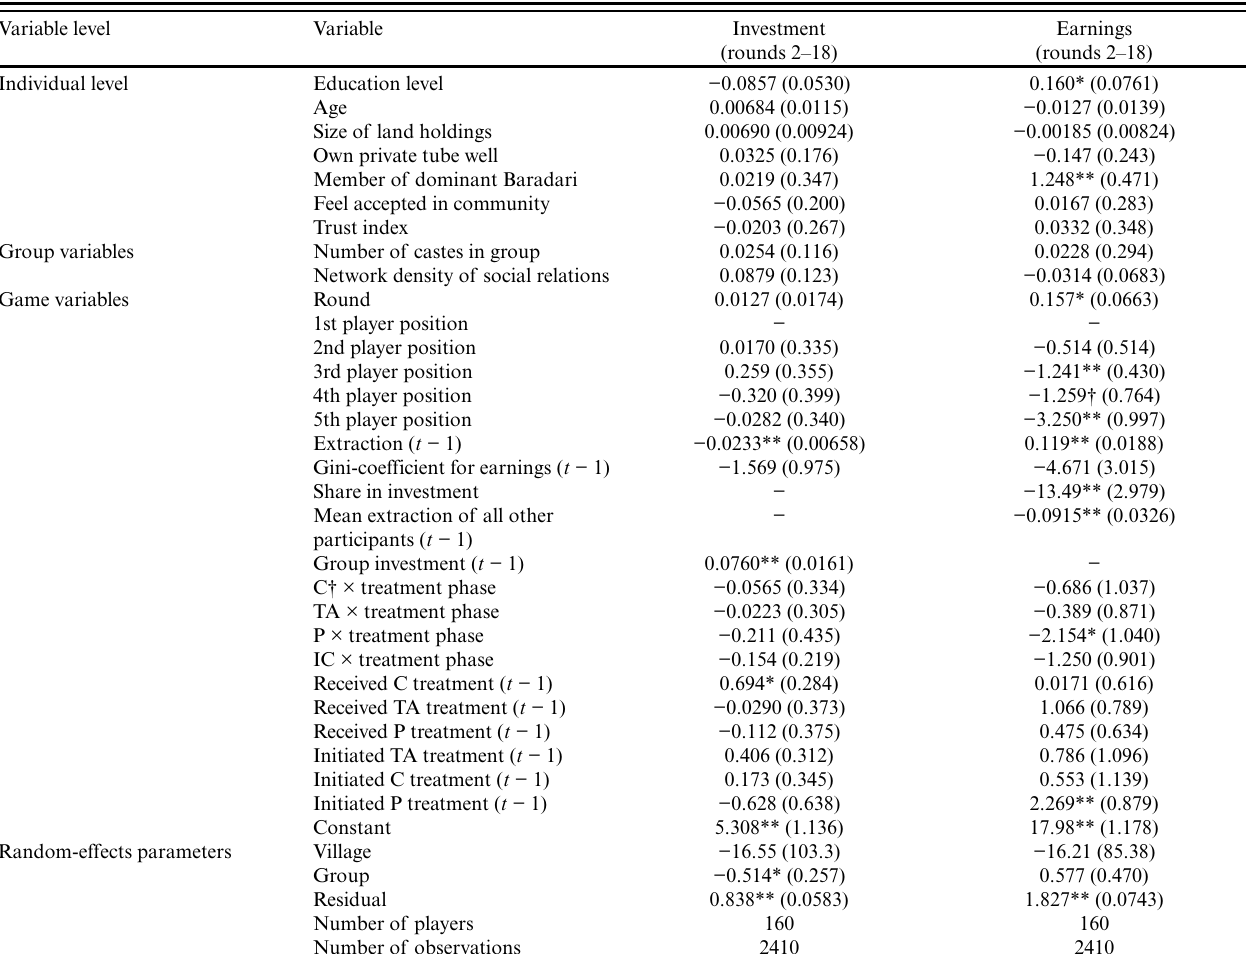
Table 2. Mixed-effects regression results of individual amounts invested and earned. Numbers are coefficients, with robust standard errors in